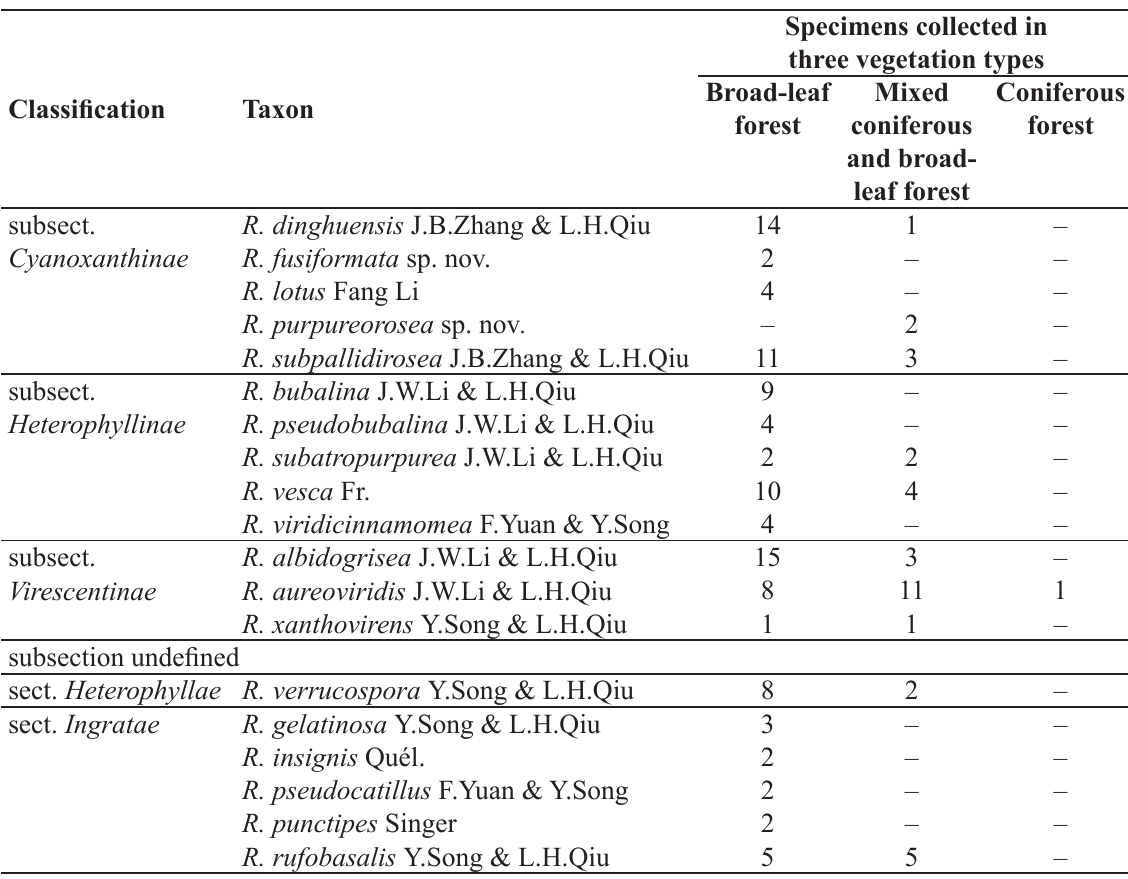
Table 2. Ecological distribution of species of Heterophyllidiae Romagnesi, emend. Buyck & V.Hofst. collected from Dinghushan Biosphere